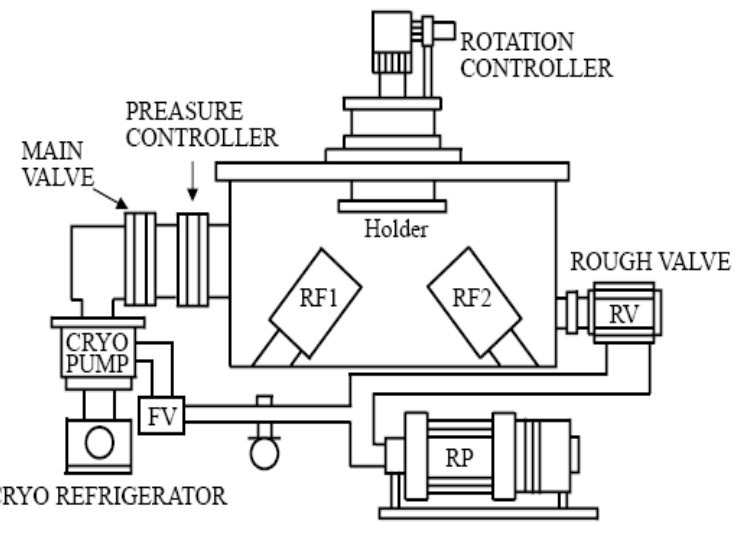
Figure 1. Schematic diagram of the co-sputtering